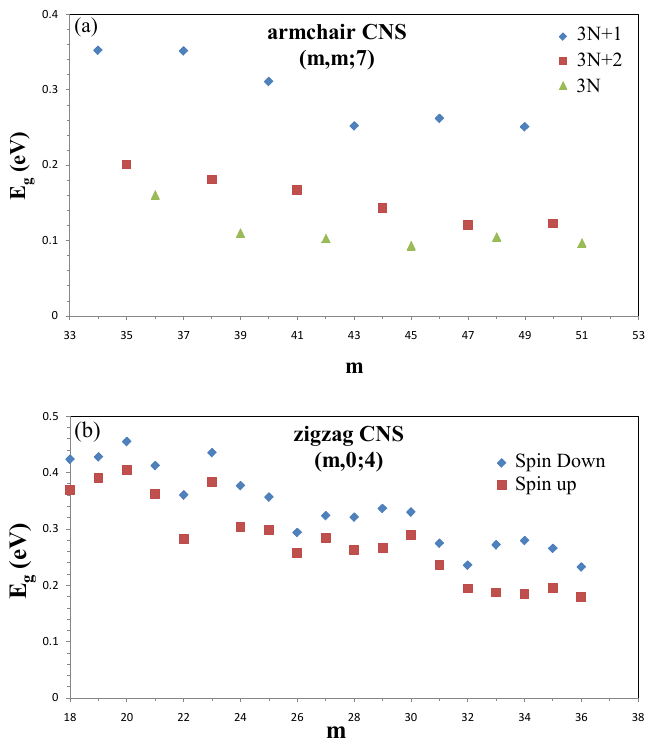
Figure 8. The width-dependent energy gaps for ( a ) armchair carbon nanoscrolls with N in = 7 and ( b ) zigzag systems with N in =